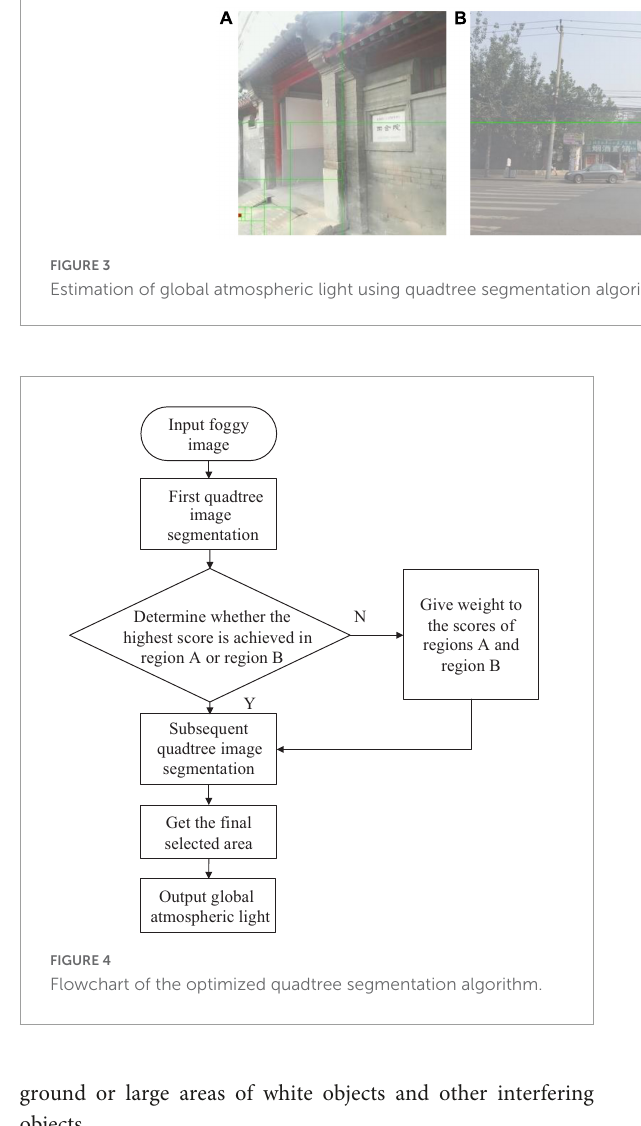
ground or large areas of white objects and other interfering